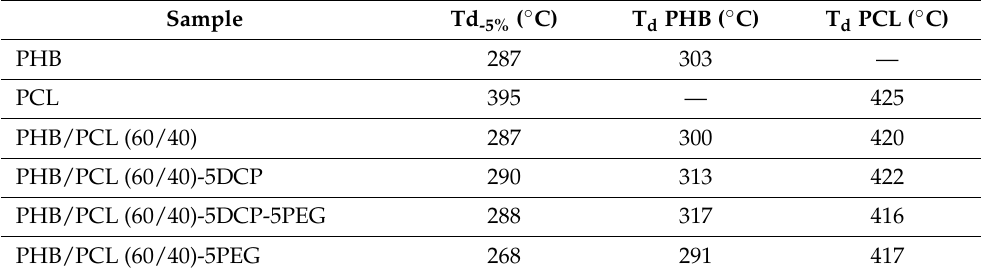
Table 4. Degradation temperature of PHB, PCL, and PHB/PCL